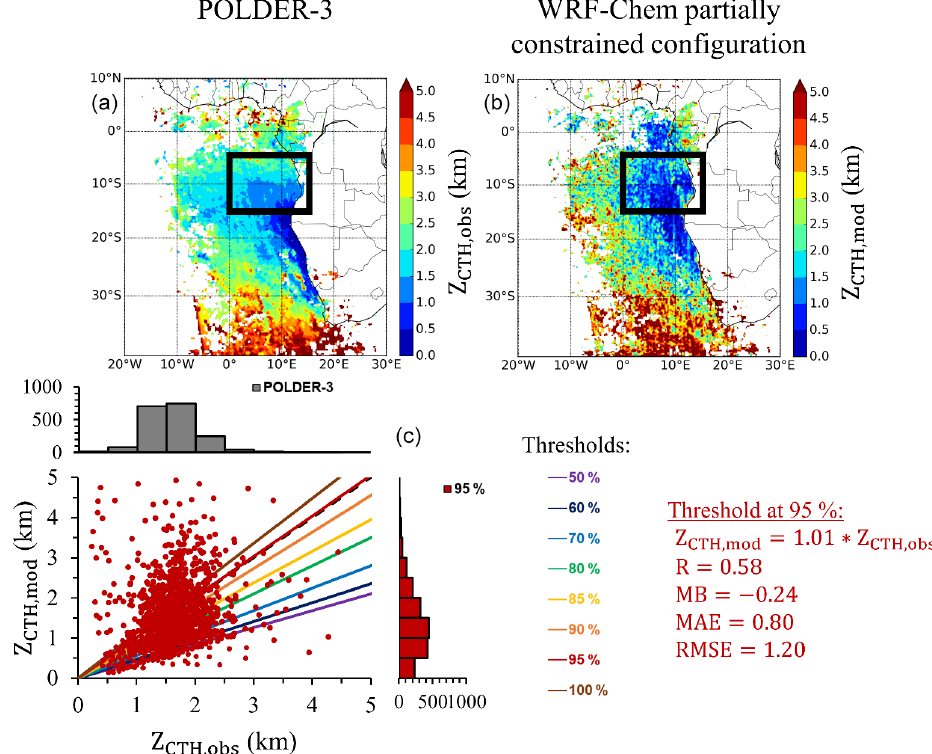
Figure 8. Monthly averaged cloud top heights retrieved by POLDER-3 (a) and simulated with the WRF-Chem partially constrained config- uration with the threshold of 95% (b) for July 2008, with an associated statistical analysis of the threshold values of the cloud top height tested in the model (c) . The black frames (0–15 ◦ E, 15–5 ◦ S) represent the area of